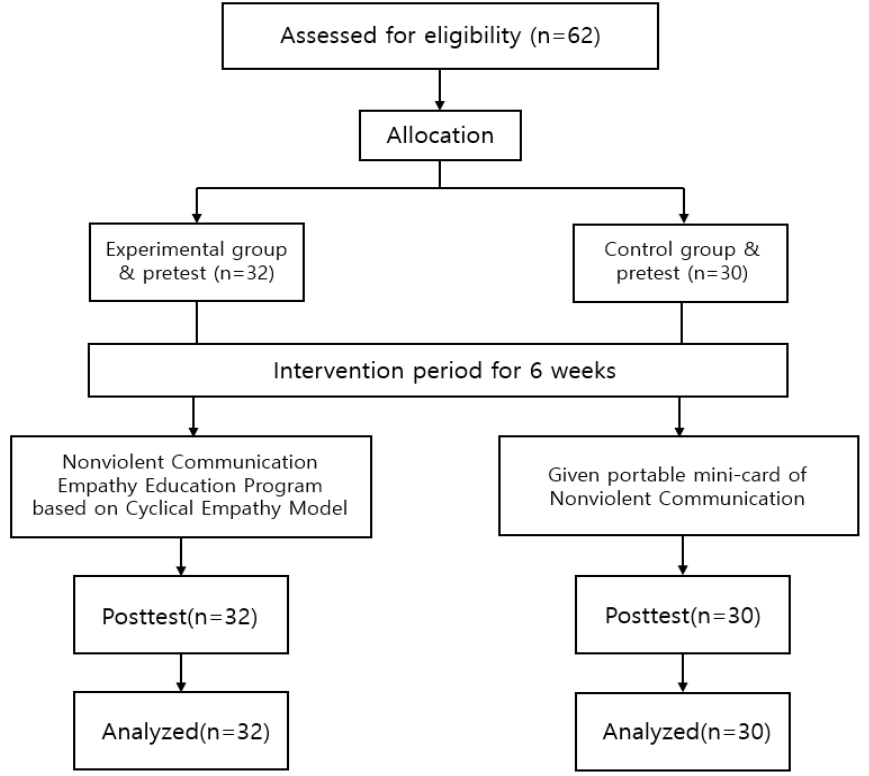
Figure 1. Participant selection flow.